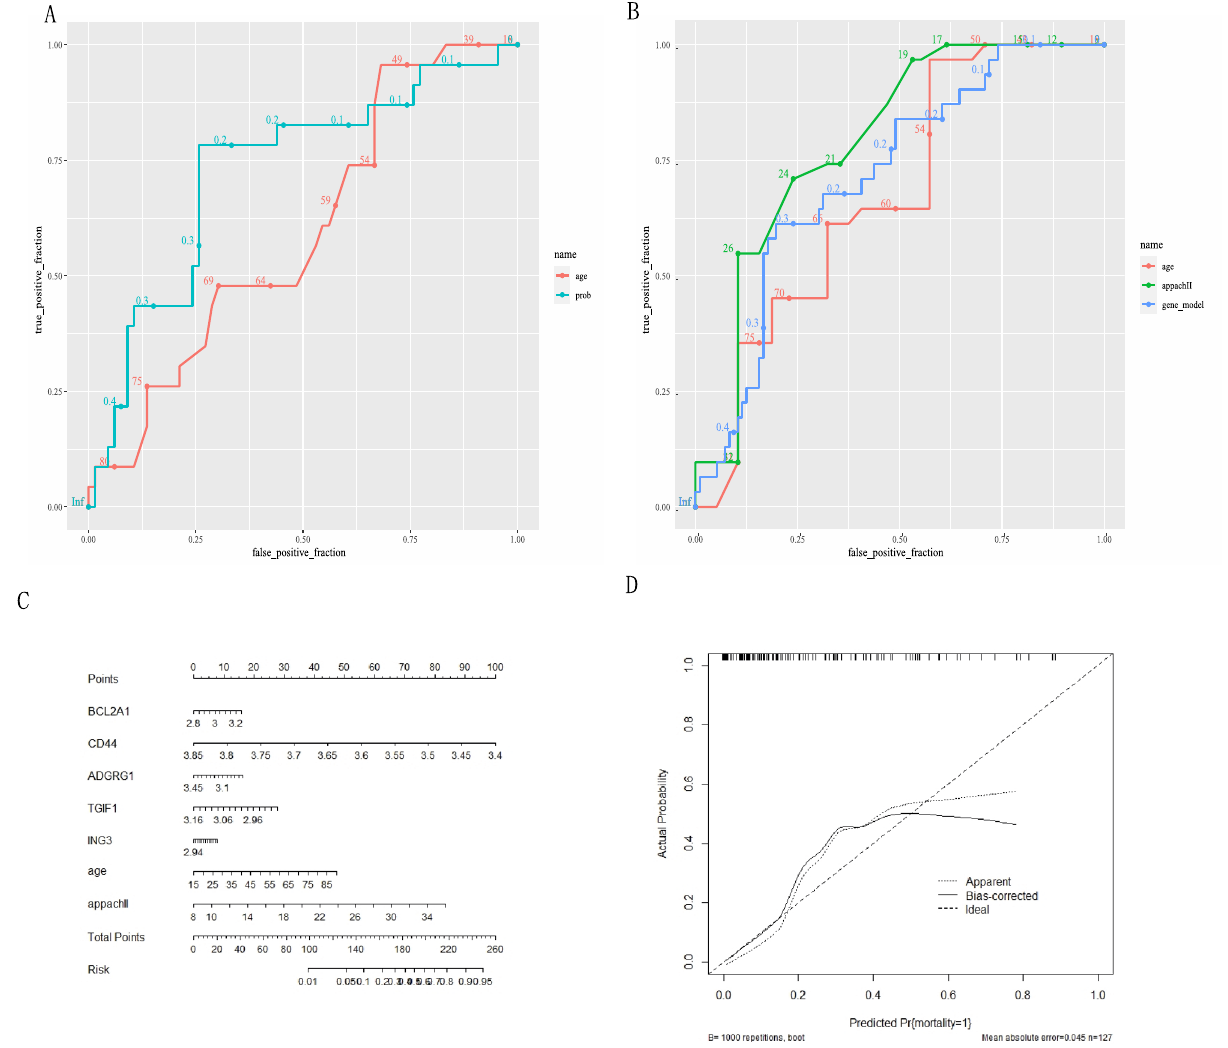
Figure 5. ( A ) Mortality prediction of gene model and age in testing dataset from GSE65682, AUC for age was 0.585 (95% CI 0.247–0.911) and the AUC for the five-gene-age model was 0.669 (95% CI 0.782–0.565). ( B ) Mortality prediction of gene model, age and Apache II scoring system in testing dataset from GSE54514. The AUC of the five-gene model was 0.718 (95% CI 0.802–0.613), the AUC of age was 0.676 (95% CI 0.427–0.968), and the AUC of APACHE II was 0.792 (95% CI 0.760–0.710). ( C ) Nomogram generated from GSE54514 integrating the risk factors available, including APACHE II scoring system, age, and five-gene model. ( D ) Calibration curve testing of nomogram generated from